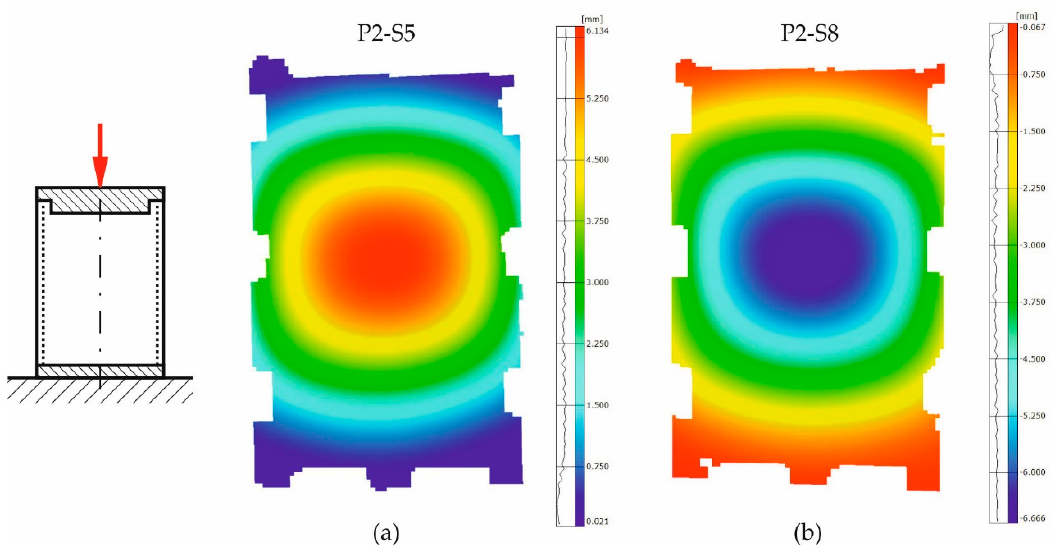
Figure A4. Qualitative illustration of out-of-plane displacement of specimen ( a ) P2-S5 and ( b ) P2-S8 measured with CAI-modified device.